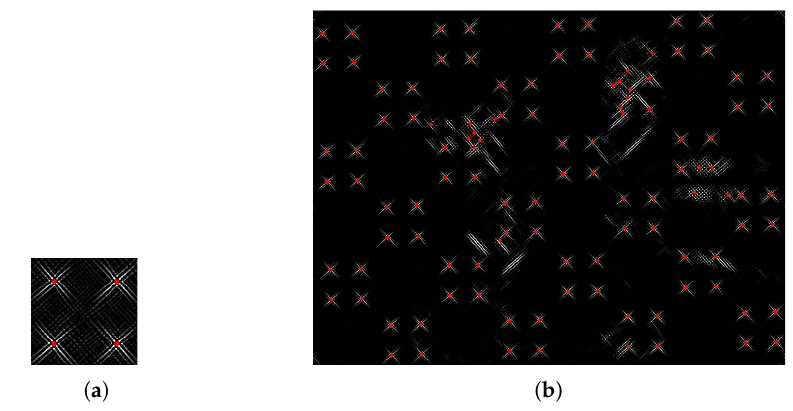
Figure 9. Template extraction results: ( a ) for one template block; ( b ) for the whole rotated image. Red dots are points detected by corner